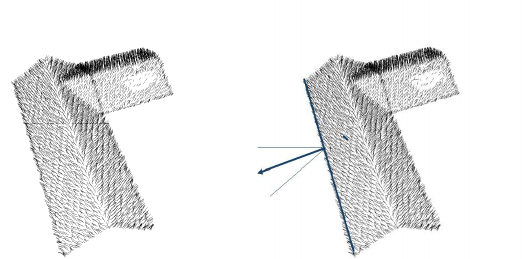
Figure 2. Surface normals of the Delaunay Triangulation (left), test of the orthogonality of a surface normal in reference to a building side (right)